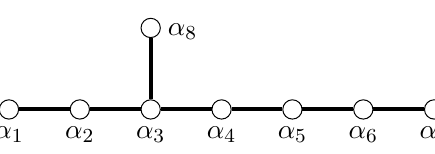
Figure 5 . Our convention for the labeling of the simple roots of E 8 .